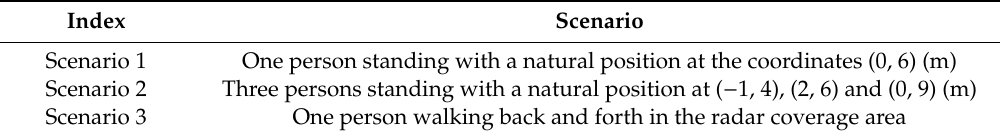
Figure 20. Experimental setup. Table 5. Experimental